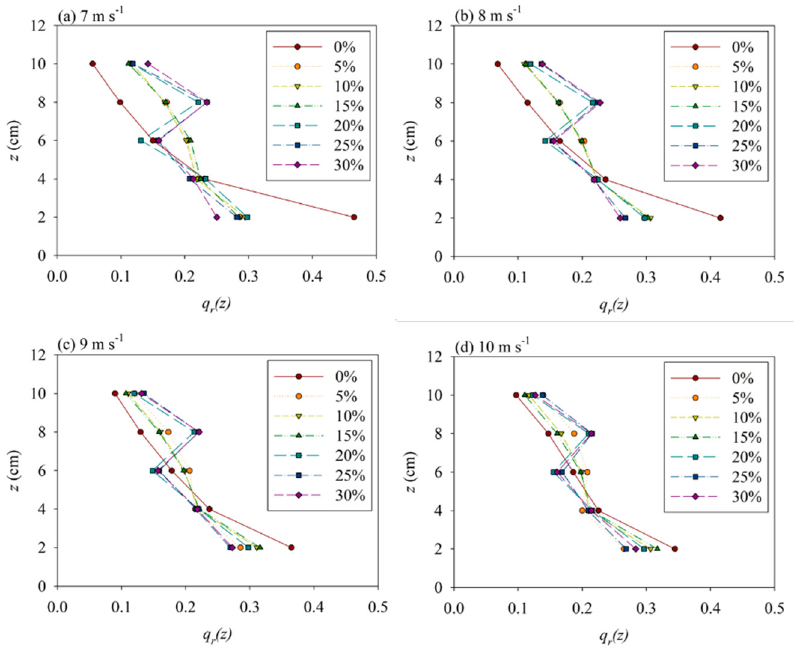
Figure 7. Comparison of vertical profiles of relative blown-sand flux q r ( z ) in Equation (3) for the same gravel coverages as in Figure 4 for the wind speeds of ( a ) 7, ( b ) 8, ( c ) 9, and ( d ) 10 m s − 1 in Figure 3. A sand bed the same as that used in Figure 3 was used to represent the 0% gravel surface.